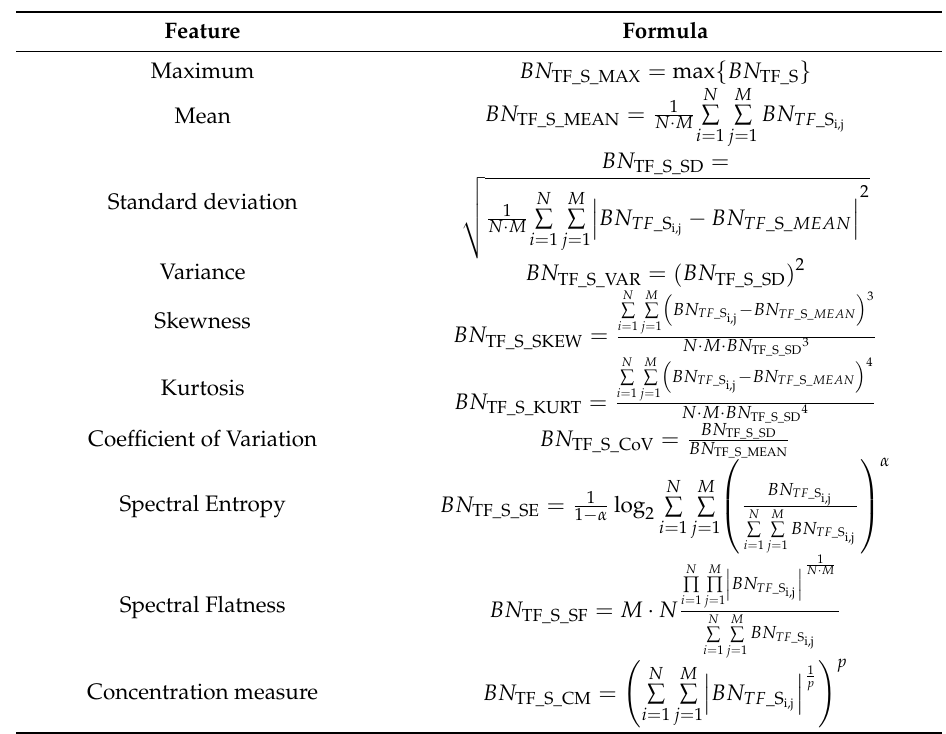
Table 1. Definition of selected features calculated based on spectrogram BN TF_S of TF representation S BN ( t , f ) 1